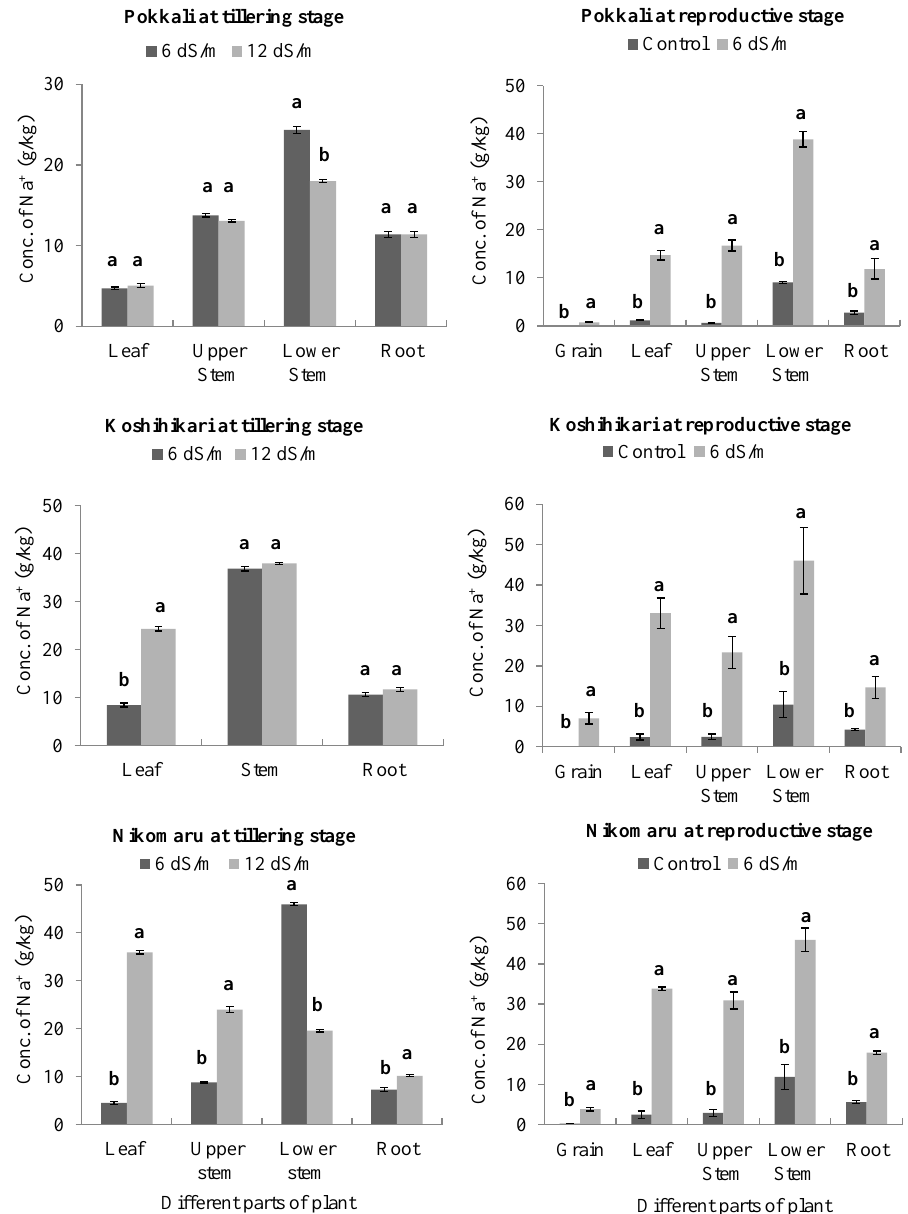
Figure 2. Average concentration of sodium ions in different parts of the rice plant body in the tillering stage (under 6 and 12 dS/m saline irrigation) and in the reproductive stage (under control and 6 dS/m saline irrigation). Error bars represent standard errors ( n = 6). Different letters on bars indicate statistical difference at p ≤